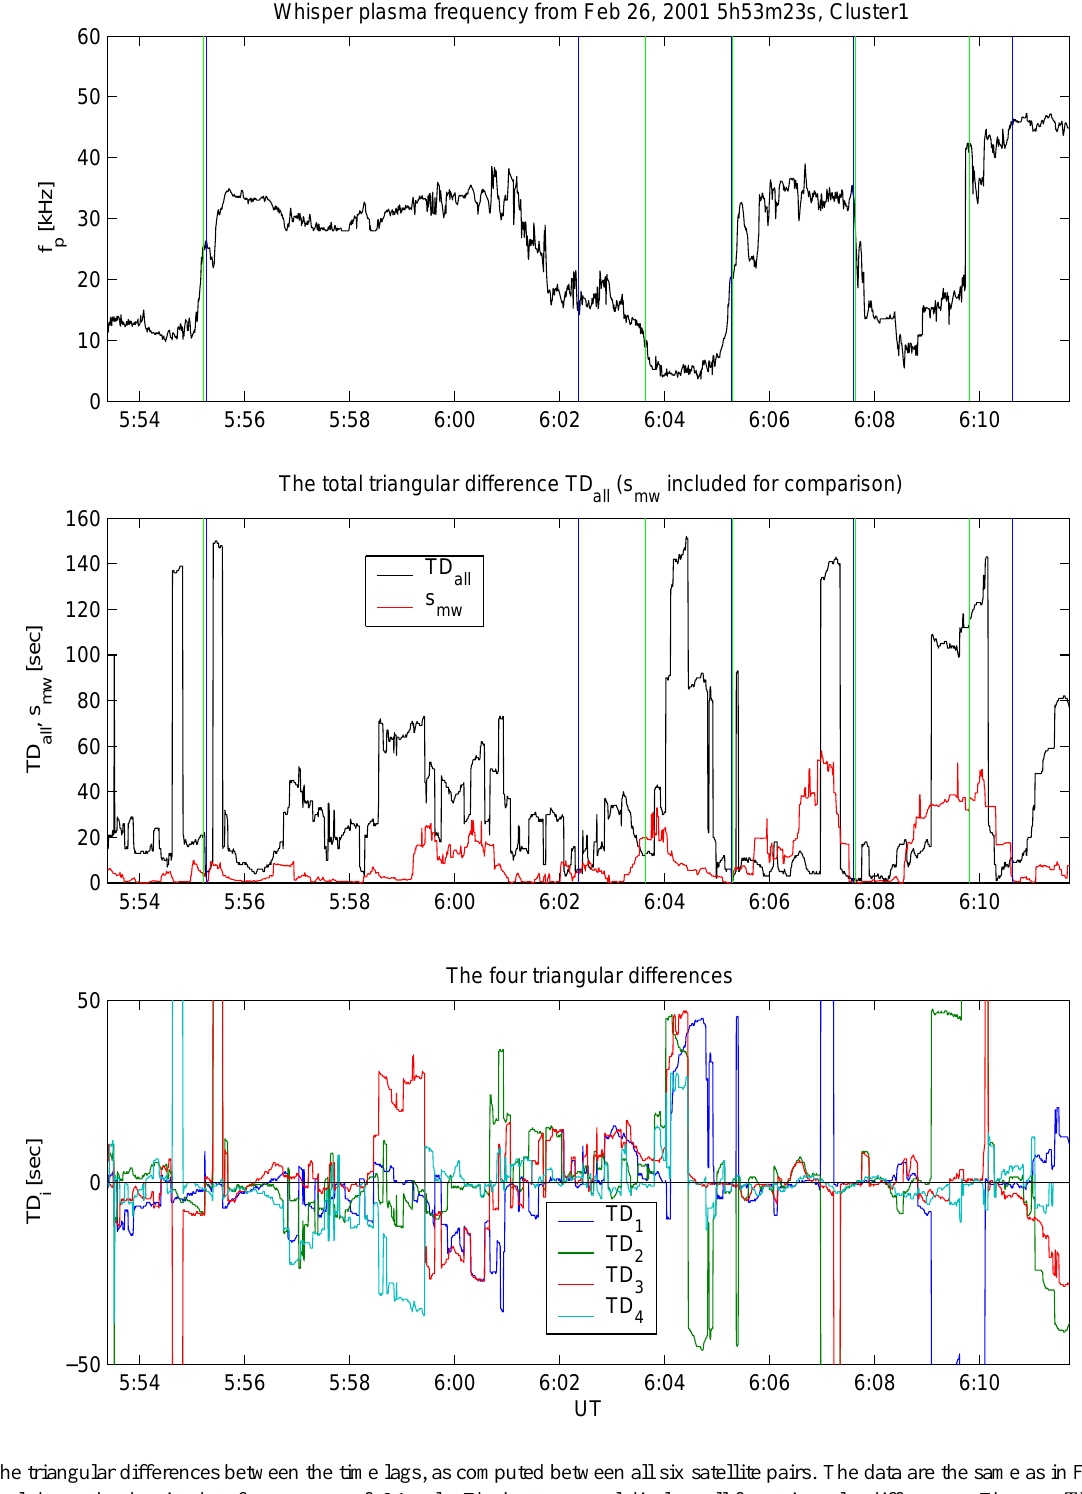
Fig. 4. The triangular differences between the time lags, as computed between all six satellite pairs. The data are the same as in Fig. 1. The upper panel shows the density data from spacecraft C1 only. The bottom panel displays all four triangular differences. The sum TD all of the triangular differences, and the standard deviation s mw are displayed in the central